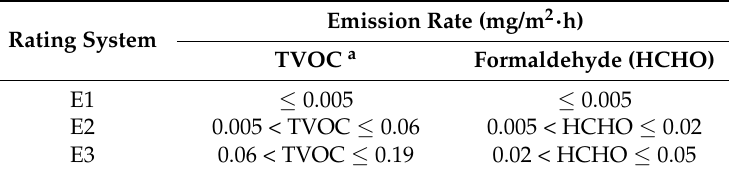
Table 4. Rating system of healthy GBM in